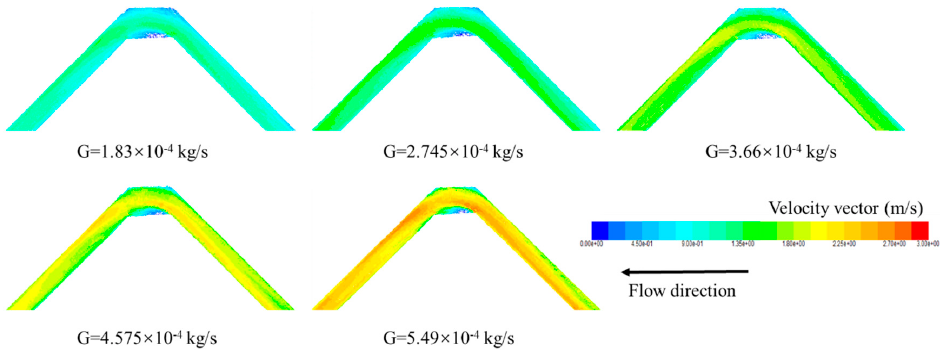
Figure 13. Velocity vectors of Np = 10 at di ff erent mass flow rates.